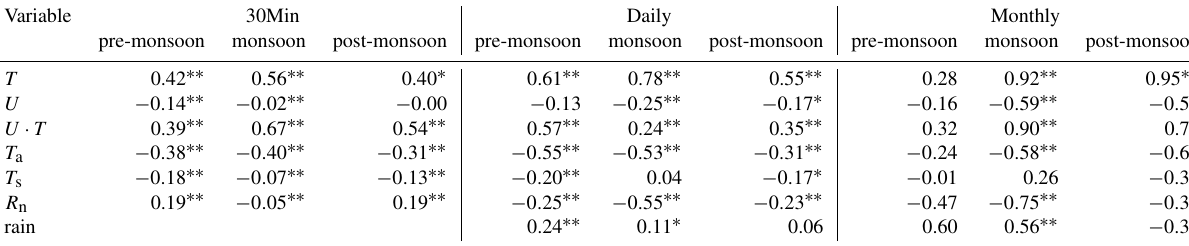
Table 2. The Pearson correlation coefficients between 30Min, Daily and Monthly sensible heat flux ( H s ) and difference between water surface and air temperature ( (cid:49)T ), wind speed ( U ), the product of wind speed and difference between water surface and air temperature ( U · (cid:49)T ), air temperature ( T a ), water surface temperature ( T s ), net radiation ( R n ), and rain, during pre-monsoon, monsoon and post-monsoon periods for the whole study period (2012 to 2015). The significant levels of 0.01 and 0.05 are marked with ∗∗ and ∗ , respectively. The correlation coefficients between rain and H s are estimated only at daily and monthly timescales.